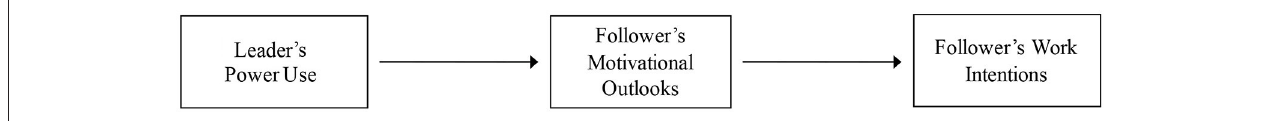
FIGURE 1 | Overall conceptual